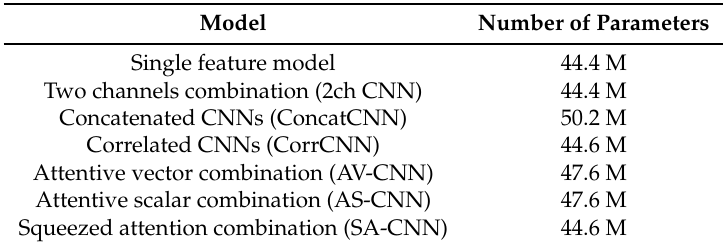
Table 2. Approximate number of trainable parameters per